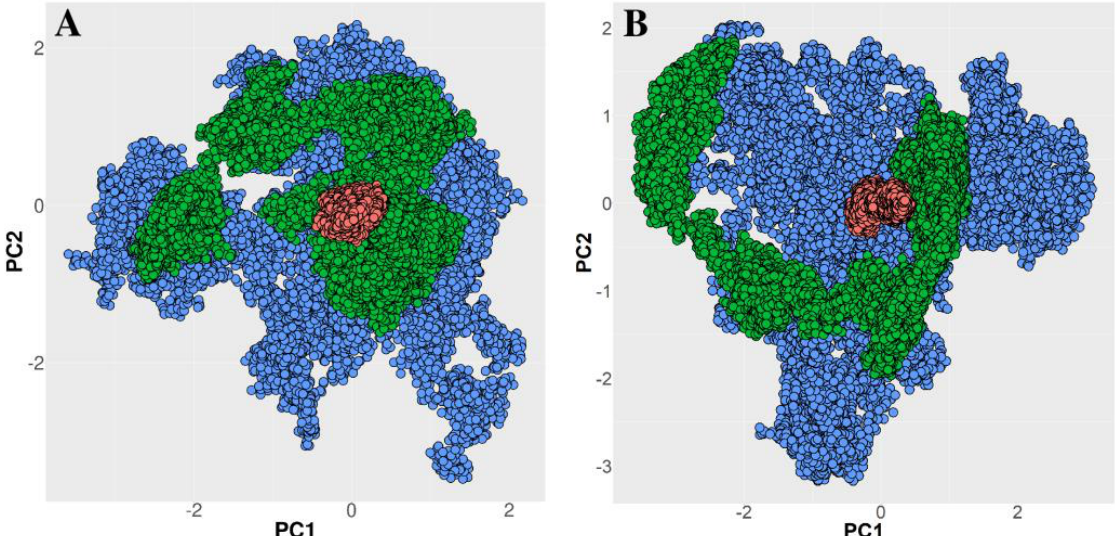
Figure 5. ( A ) Free-energy profile of TFO unbinding from the DH, calculated along a minimum energy path, as a function of a generalized ‘Reaction Coordinate’ for the DIPRO5 (red line), DIPRO15 (green line) and DIPRO25 (blue line) switches. ( B ) Free-energy profile of TFO unbinding from the DH, calculated along a minimum energy path, as a function of a generalized ‘Reaction Coordinate’ for the TETRA5 (red line), TETRA15 (green line) and TETRA25 (blue line) switches. For all the systems, the free energy profile is characterized by the presence of three minima, corresponding to the bound state ( B ) and two intermediate (I 0 and I 1 ) states. The Ts unb state represents the final step of the ABMD simulations.